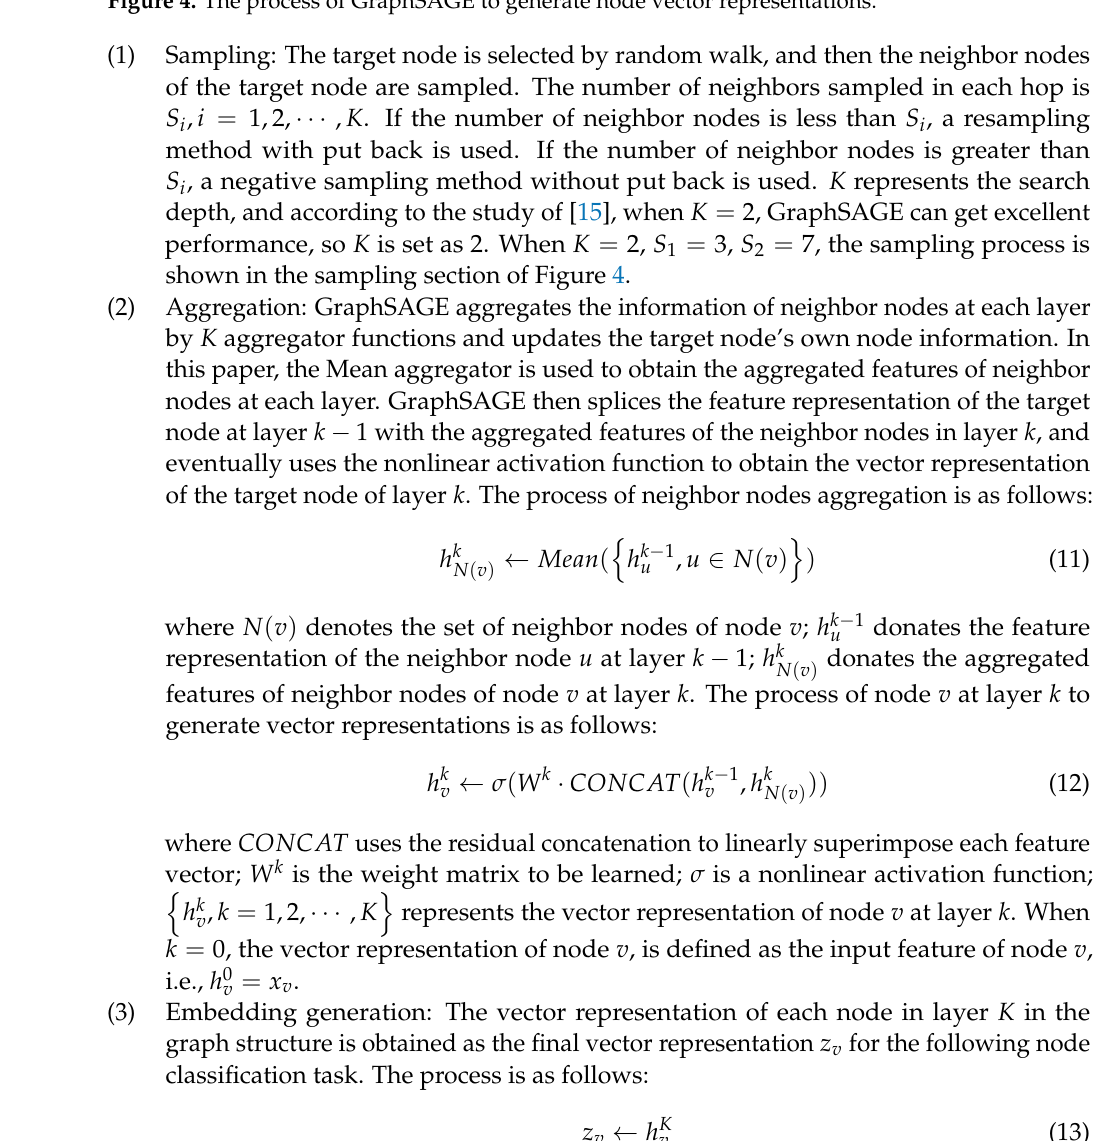
Figure 4. The process of GraphSAGE to generate node vector representations.